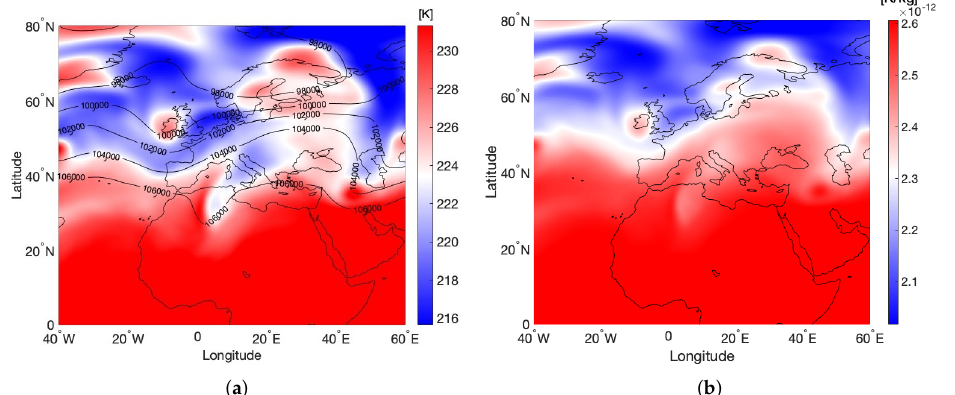
Figure 2. Meteorological parameters and O 3 aCCFs at 250 hPa: ( a ) geopotential (isolines, m 2 /s 2 ) and temperature (isolines, K), ( b ) O 3 aCCFs (colour contours, K/kg(NO 2